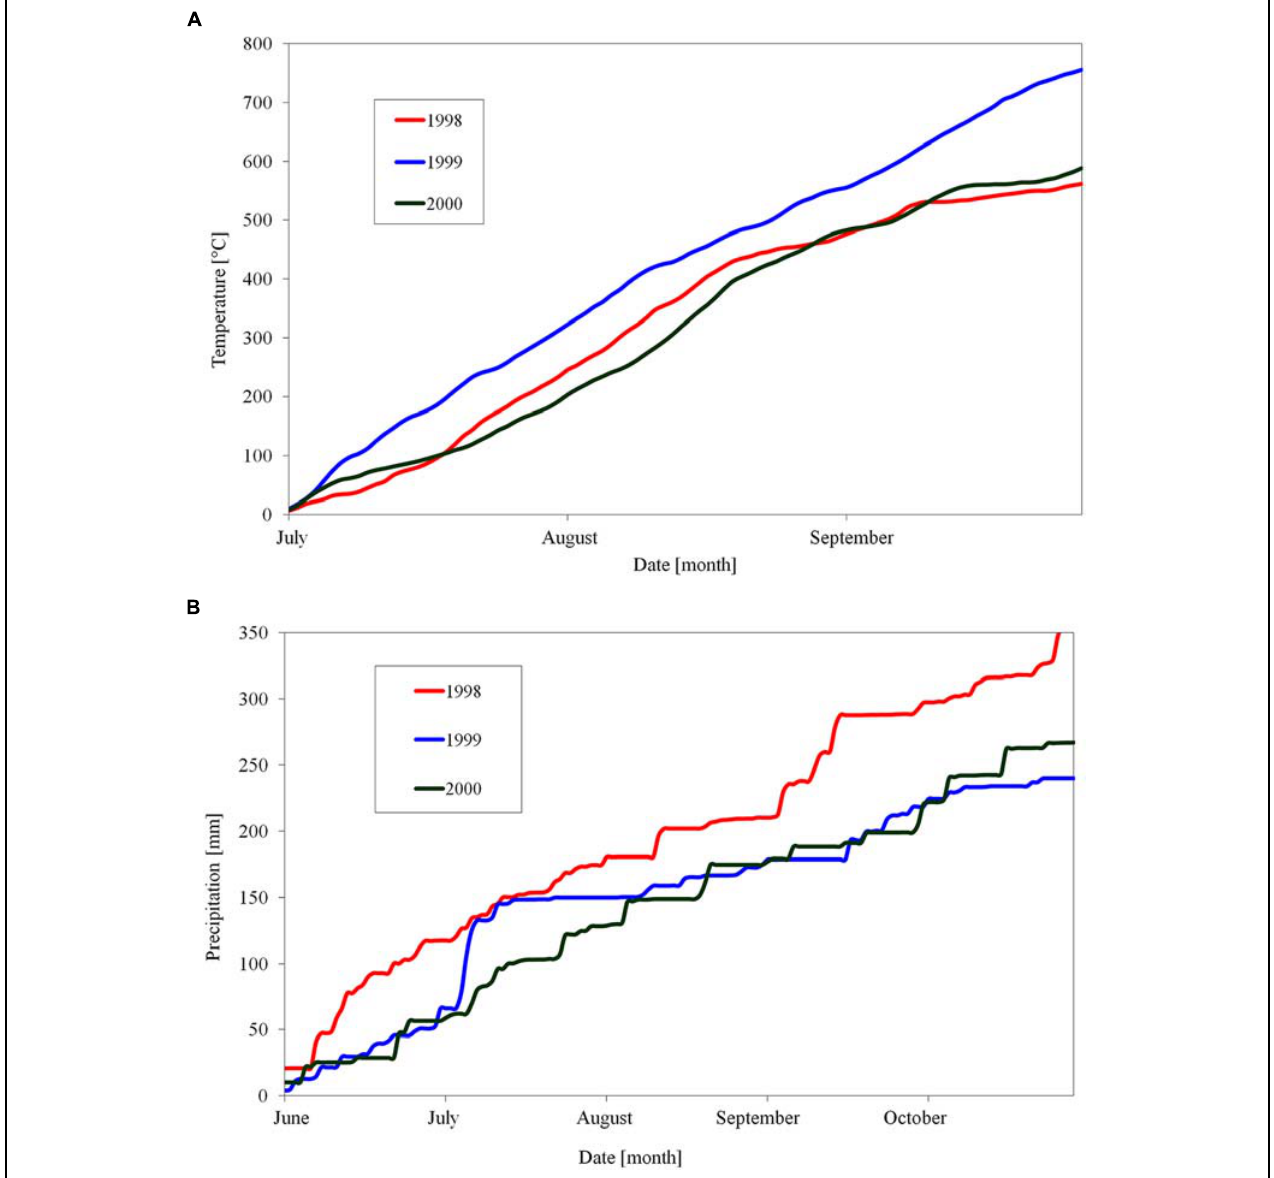
FIGURE 1 | Cumulative sum of day temperatures above 10 ◦ C (A) and day precipitation (B) in orchard of Crop Research Institute, Prague, Czech Republic, during three seasons of 1998, 1999, and